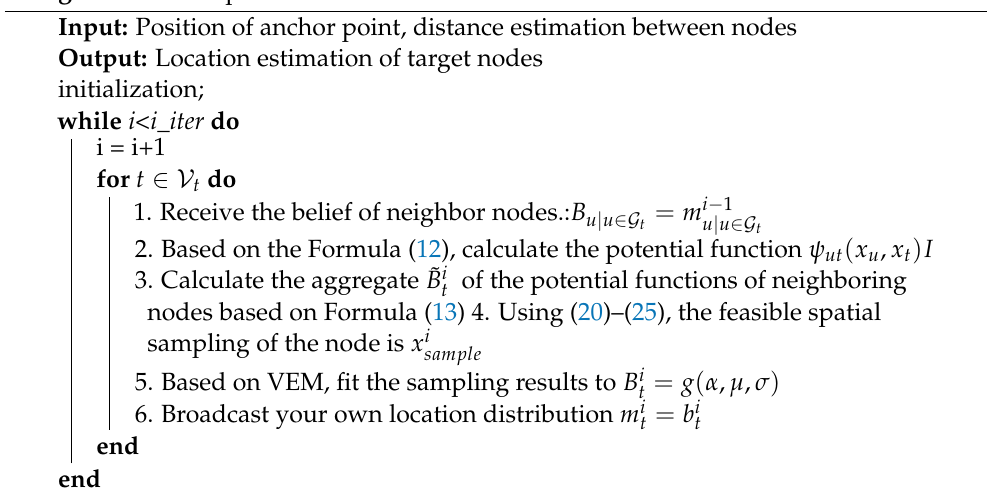
Algorithm 2: Cooperative localization based on SBPVEM